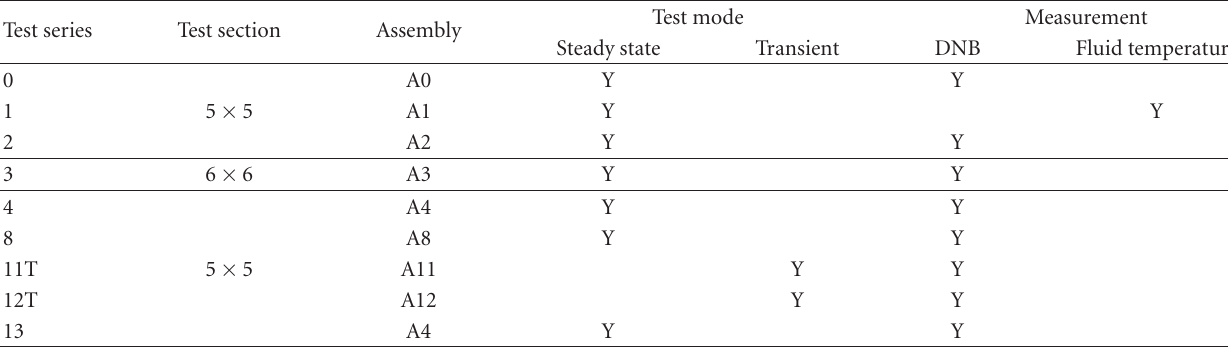
Table 9: Test series for exercise 2 of PSBT benchmark phase II [2].